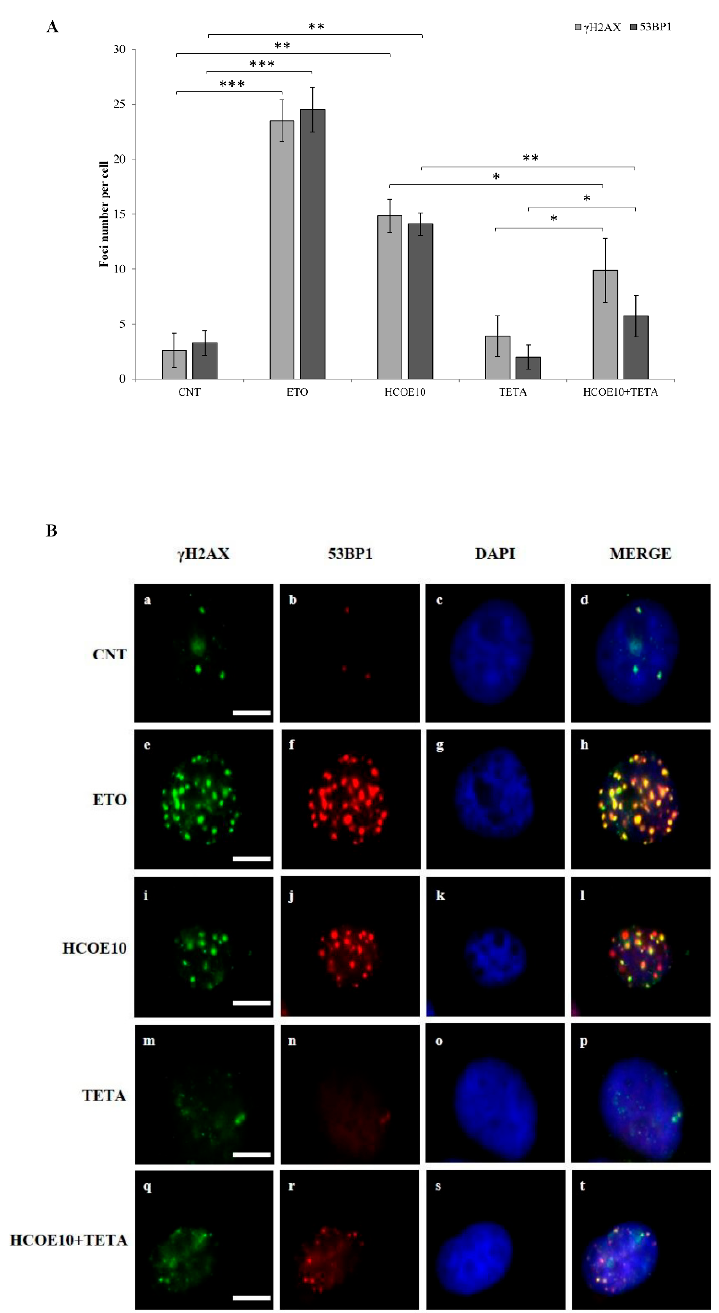
Figure 6. Immunofluorescence analysis. ( A ) The amount of γ H2AX and 53BP1 foci detected in A375 cells treated with PBS (CNT), etoposide (ETO), 10 mg / mL HCOE (HCOE10), triethylenetetramine (TETA) or HCOE10 + TETA were counted. Results are expressed as mean of foci per cell ± SD of three independent experiments (* p < 0.05; ** p < 0.01; *** p < 0.001 vs. control). ( B ) Representative immunofluorescence images of A375 cells treated with PBS (CNT) ( a–d ), etoposide (ETO) ( e–h ), 10 mg / mL HCOE (HCOE10) ( i – l ), triethylenetetramine (TETA) ( m – p ), or HCOE10 + TETA ( q – t ) are shown. γ H2AX foci are in green, 53BP1 foci are in red, while nuclei were stained in blue with DAPI. Merged images are also reported. The white bars indicate 15 µ